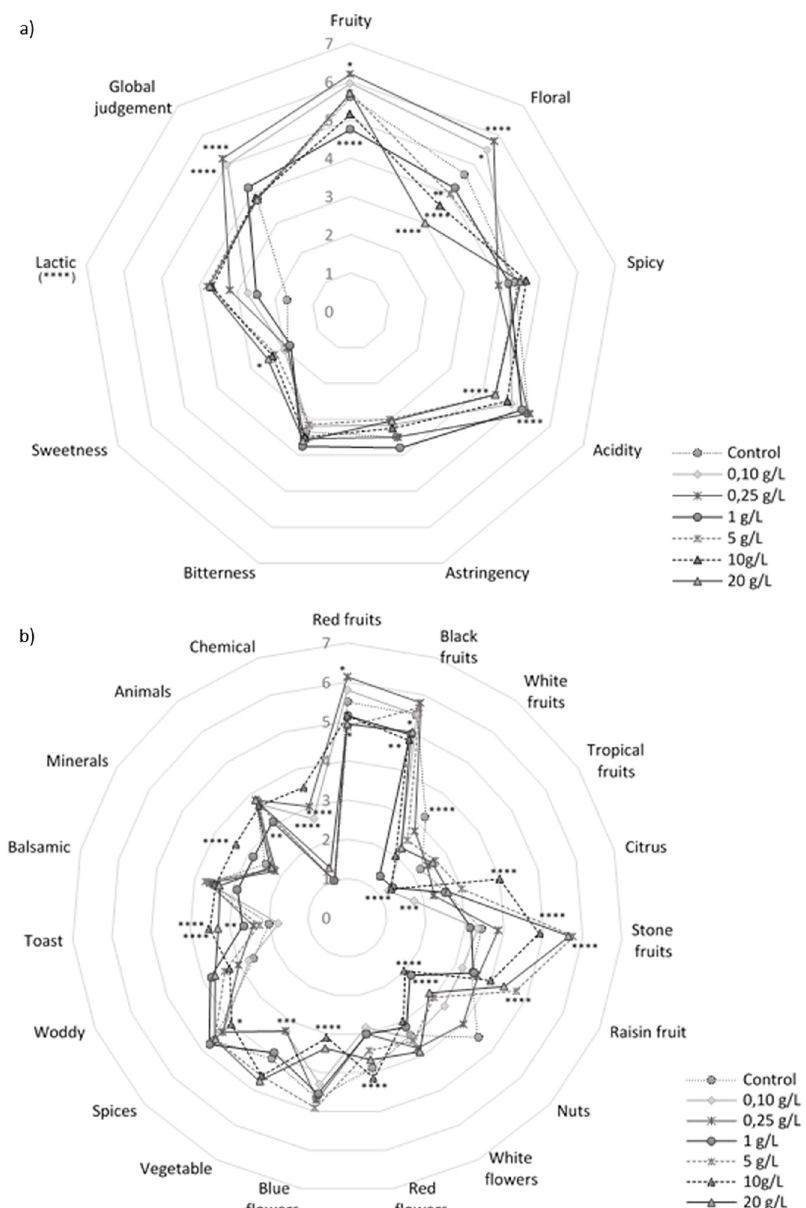
Figure 1. Tintilla de Rota red wines sensorial evaluation results of generic attributes ( a ), and specific olfactory attributes ( b ). * indicates level of significance for two-way ANOVA (BSD-test) (* p < 0.05, ** p < 0.01, *** p < 0.001 and **** p < 0.0001).